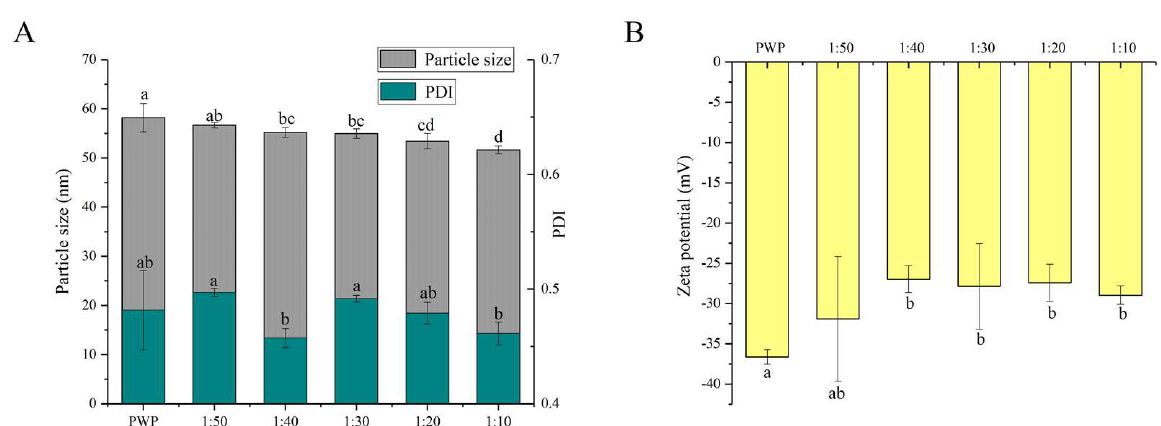
Figure 2. ( A ) Particle size, PDI and ( B ) zeta potential of PNS-PWP nanoparticles at different mass ratio of PNS to PWP. Different subscript letters indicate a significant difference ( p < 0.05).